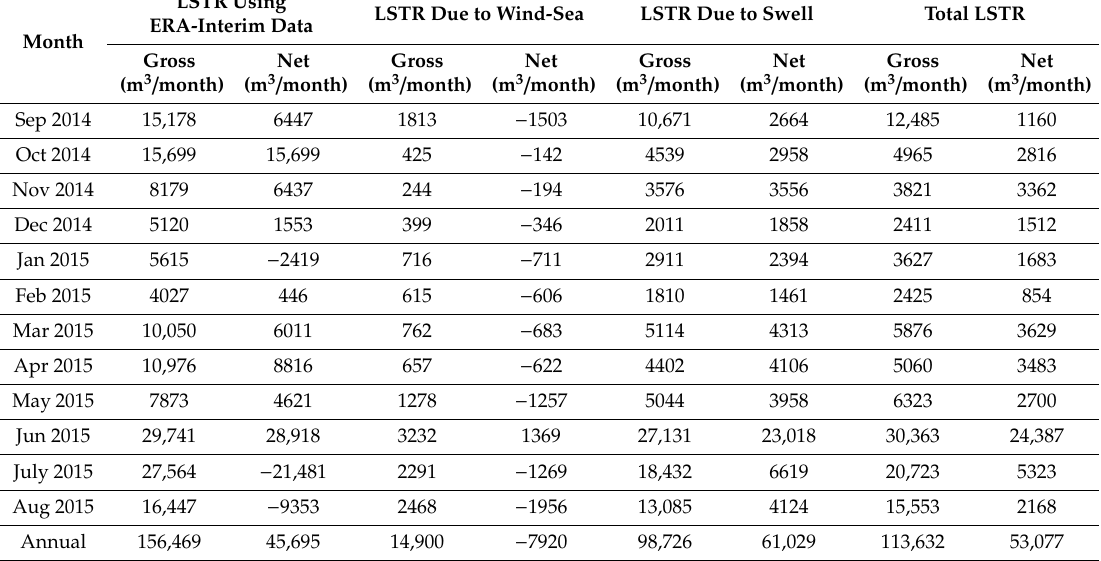
Table 6. Monthly net and gross longshore sediment transport rate using the measured buoy data separated into wind-sea and swell and ERA-Interim